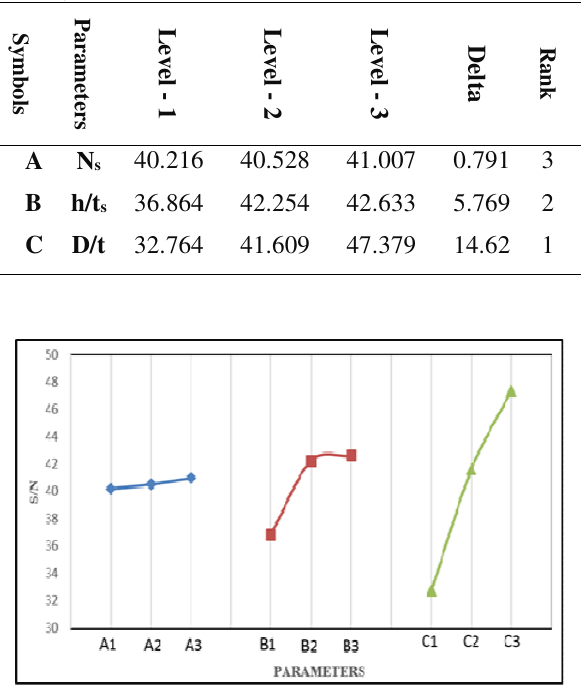
Fig. 8. The parameters- S/N curves